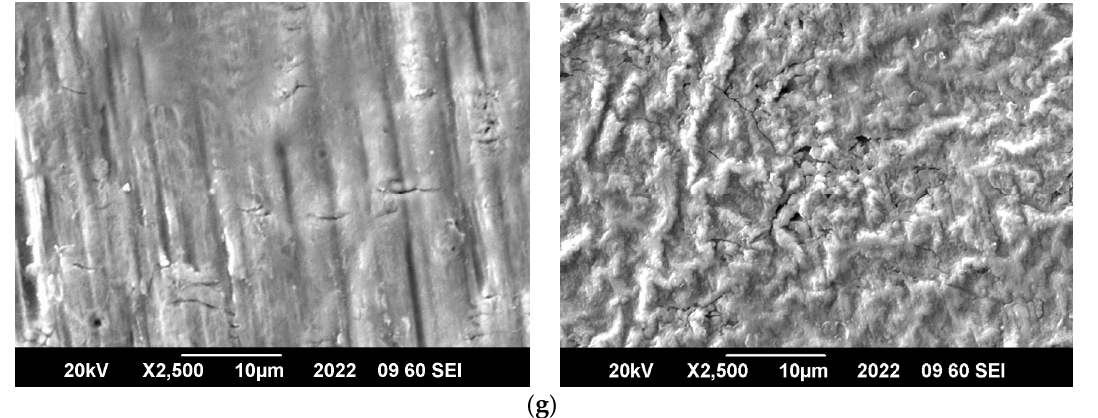
Figure 5. SEM micrograph of samples in the form of ( a ) untreated, ( b ) 2 shots, ( c ) 4 shots, ( d ) 6 shots, ( e ) 8 shots and ( f ) 10 shots. ( g ) Comparison of samples with 8 shots (left) and 10 shots (right) at magnification of 2500×. Table 1. EDX elemental composition of the